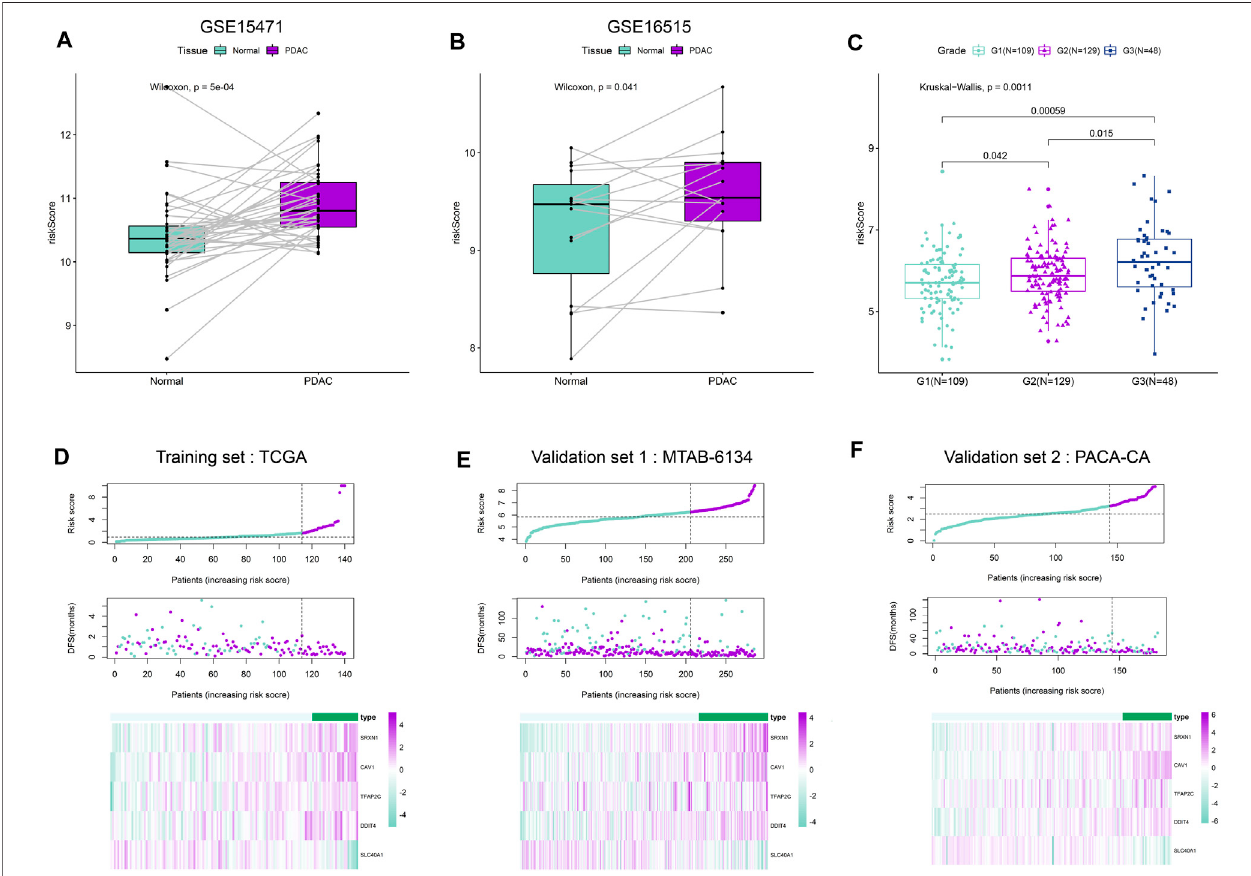
FIGURE2| Distributionoftheriskscore. (A , B) DistributionofriskscoresinPDACtissuesandpairedadjacentnormaltissuesinGSE15471datasetandGSE16515 dataset. (C) Distribution of risk scores with respect to histological grade. We have calculated the p values correction using “ Benjamini & Hochberg ” method, and the adjusted p valuesare0.00177(G1vs.G3),0.042(G1vs.G2)and0.0225(G2vs.G3),respectively. (D – F) Fromtoptobottomaretheriskscoredistribution,survivalstatus distribution, and heat map analysis of fi ve genes in three independent